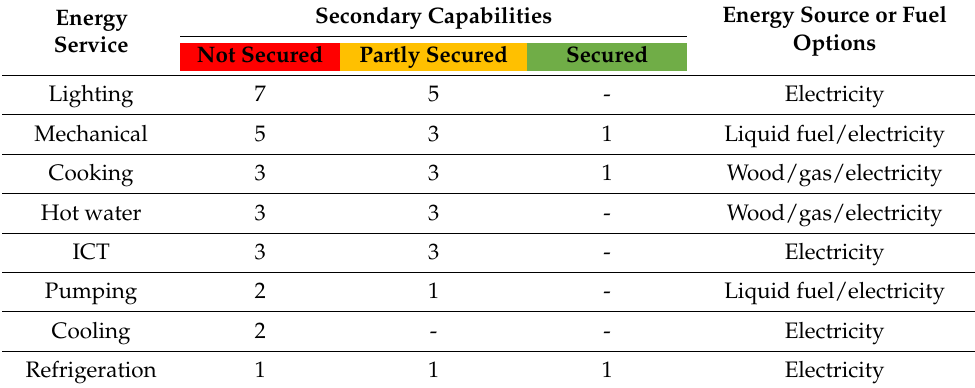
Table 2. Summary of the current state of energy service connections to secondary capabilities in